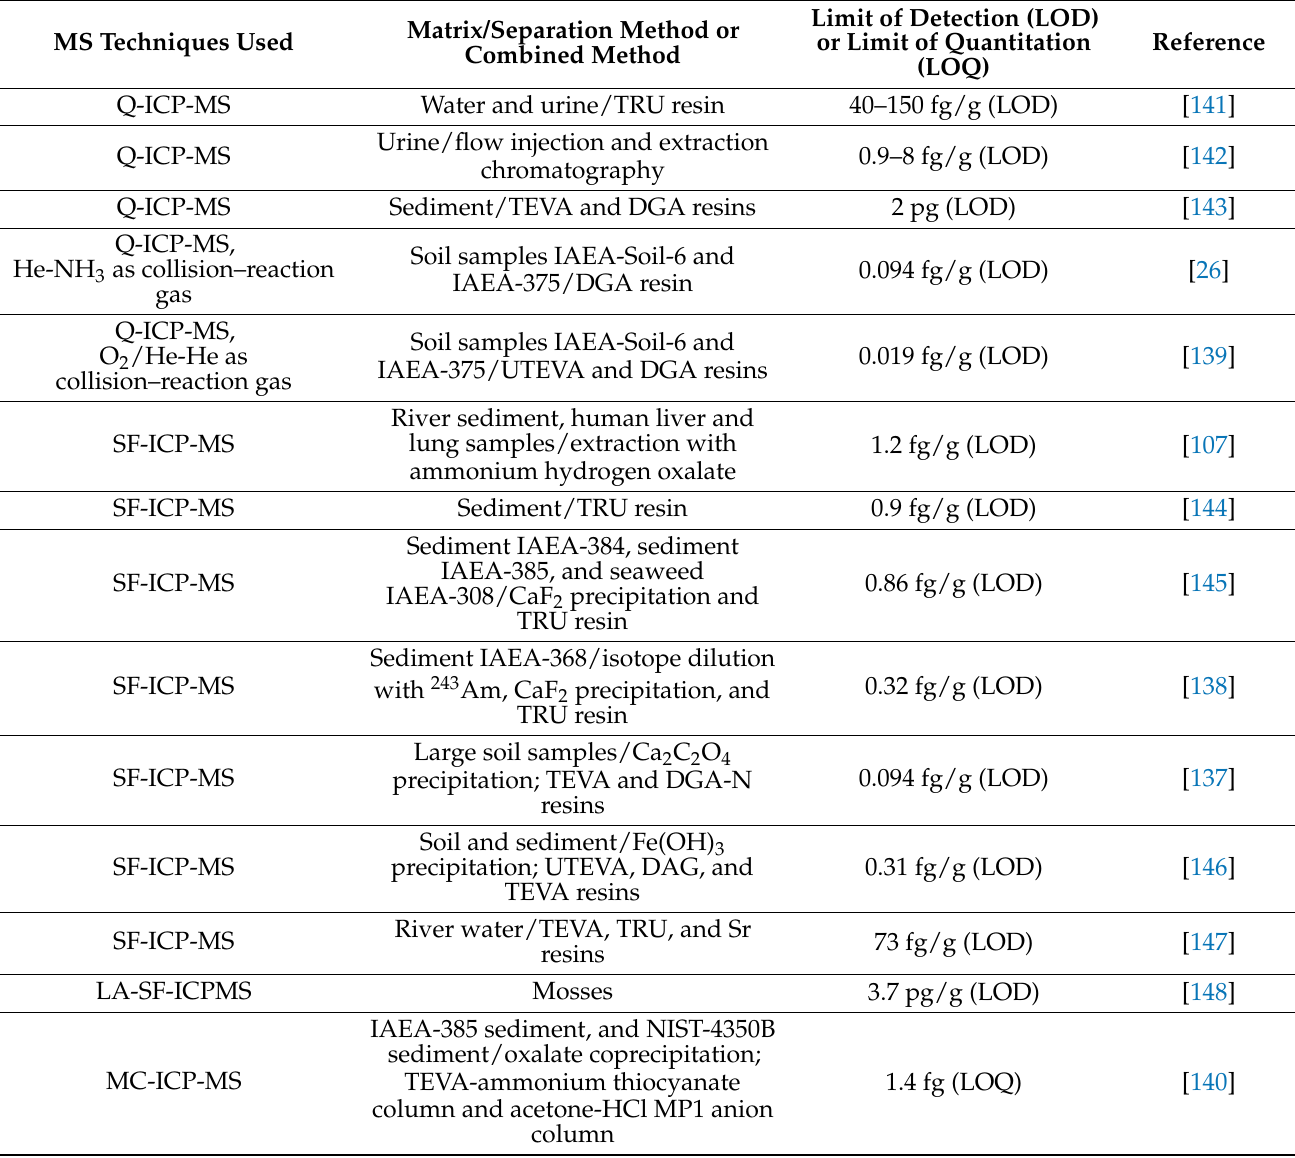
Table 9. Comparison of LODs obtained by different ICP-MS instruments for 241 Am